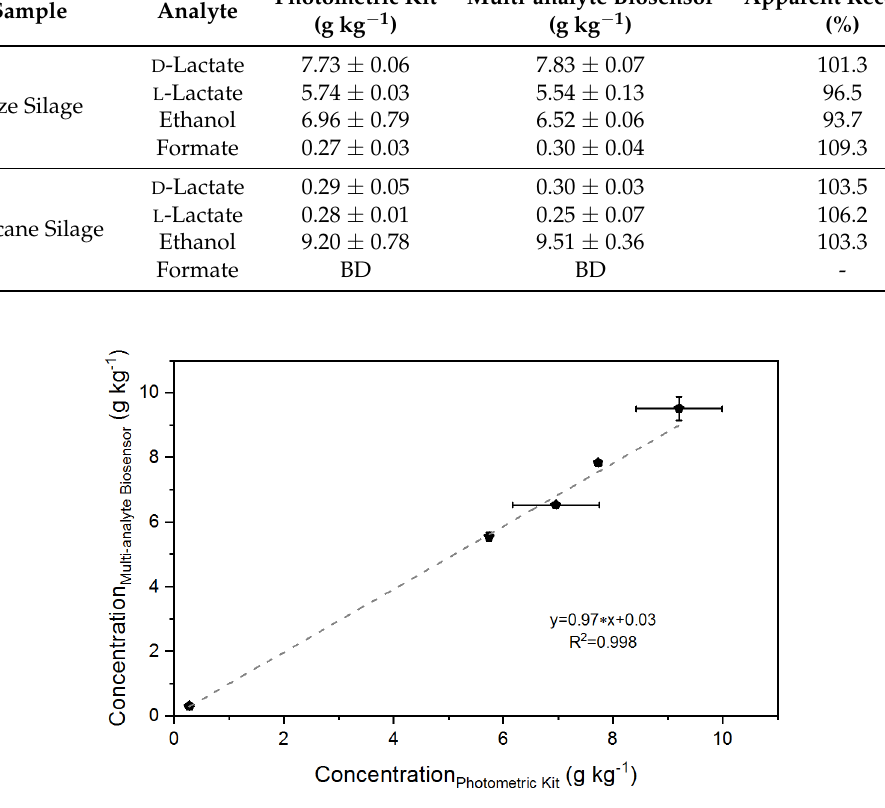
Figure 5. Comparison between the organic acid concentrations (ethanol, formate, D -lactate, and L -lactate) obtained by the amperometric and photometric